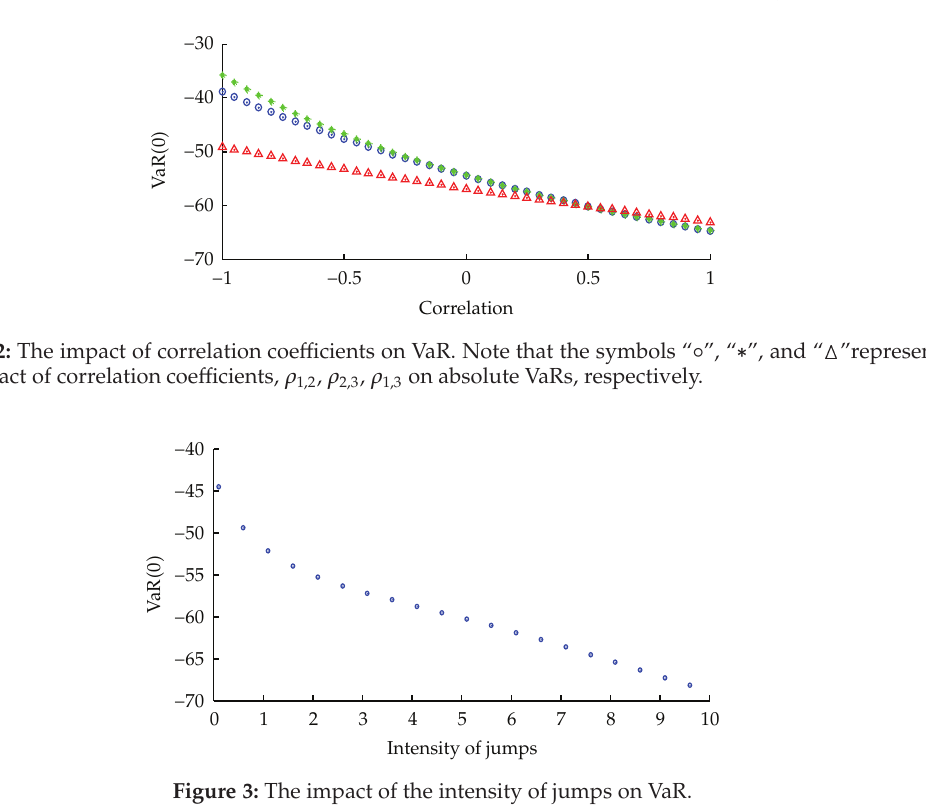
Figure 3: The impact of the intensity of jumps on